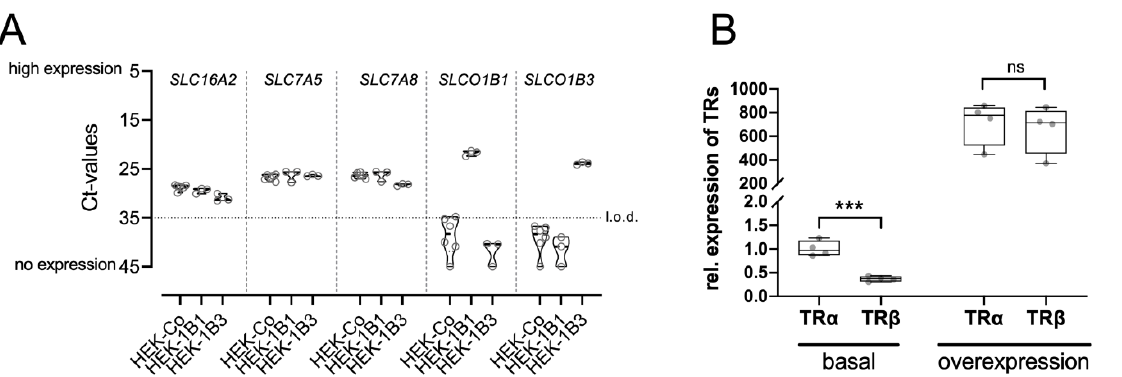
Figure 2. Expression of TH transporters and TRs in HEK293 cell lines: ( A ) RT-PCR analysis of genes encoding for TH transporters MCT8 ( SLC16A2 ), LAT1 ( SLC7A5 ), and LAT2 ( SLC7A8 ) in wild-type HEK293 cells (HEK-Co) as well as in HEK-1B1 and HEK-1B3 cells stably expressing OATP1B1 ( SLCO1B1 ) or OATP1B3 ( SLCO1B3 ), respectively. The dotted line marks the limit of detection (l.o.d.) at Ct ≥ 35. Ct = cycle threshold; LAT = l-type amino acid transporter; MCT = monocarboxylate transporter; ( B ) expression of TR α and TR β in HEK293 cells. Transient transfection led to similar expressions of both receptors. Student’s t -test: ns = not significant; *** p < 0.001.